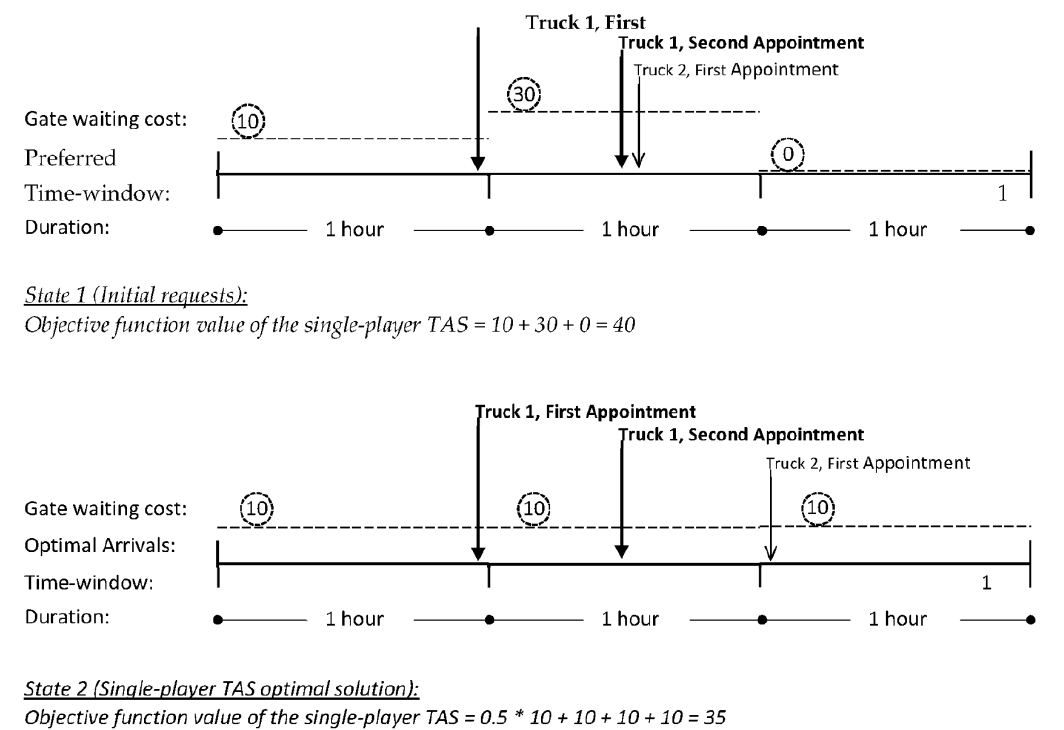
Figure 3. Solution of illustrative example using single-player